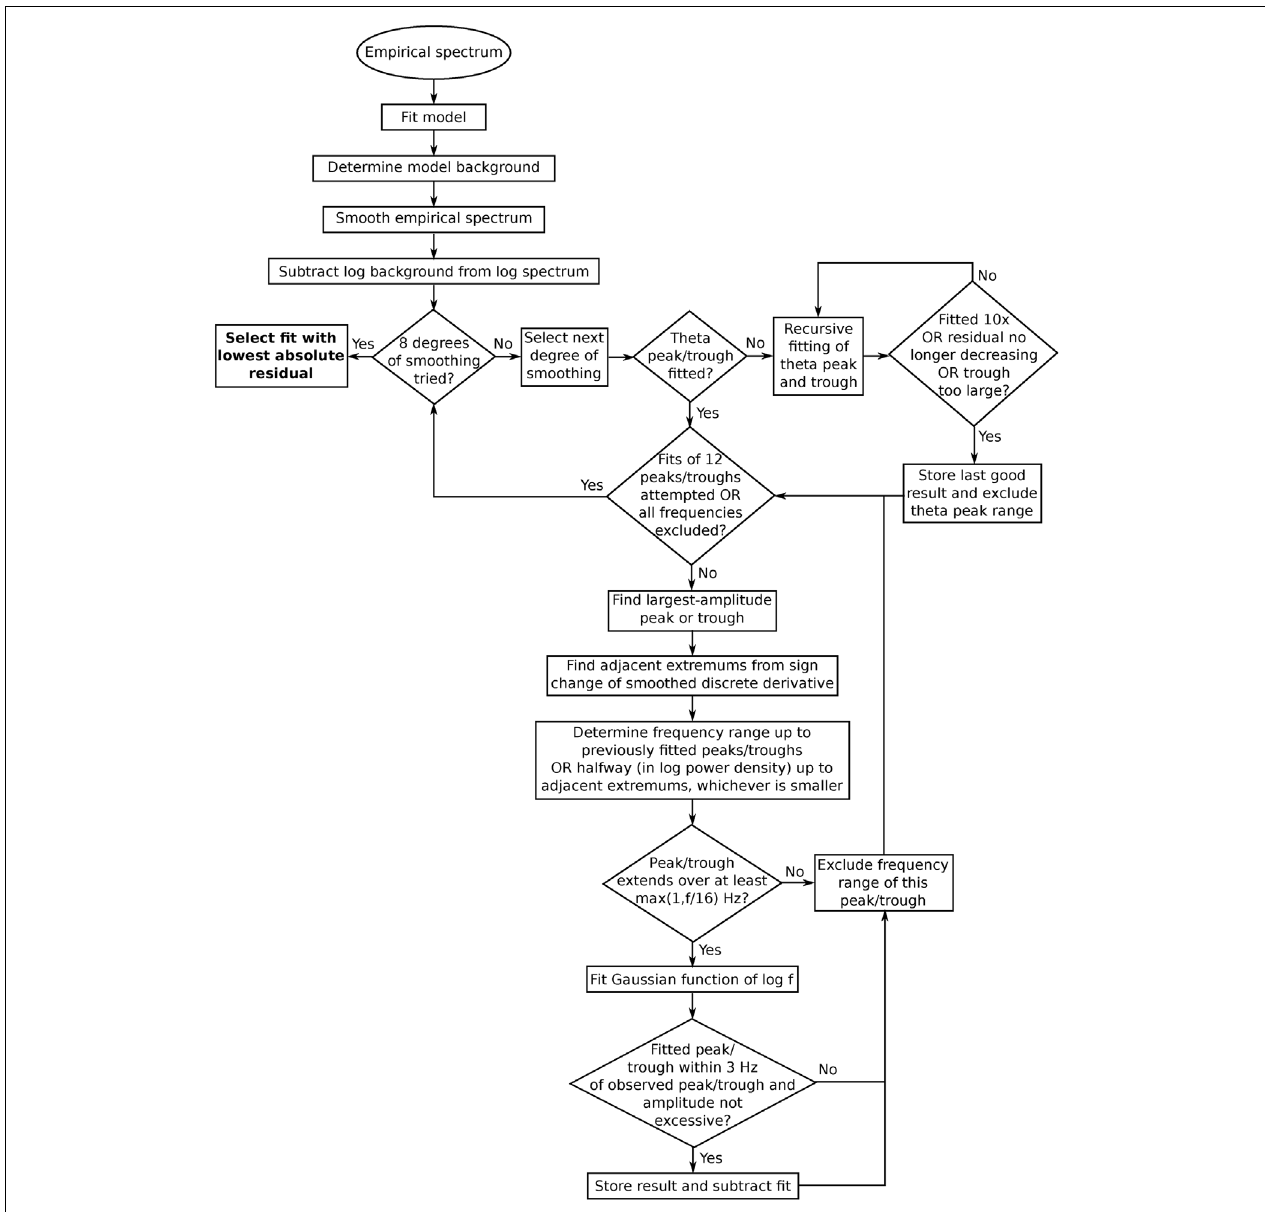
whereas a high degree of smoothing tends to yield broad ones. Different degrees of smoothing may be appropriate for different levels of noise. Such smoothing improved the agreement between fitted and visually identified